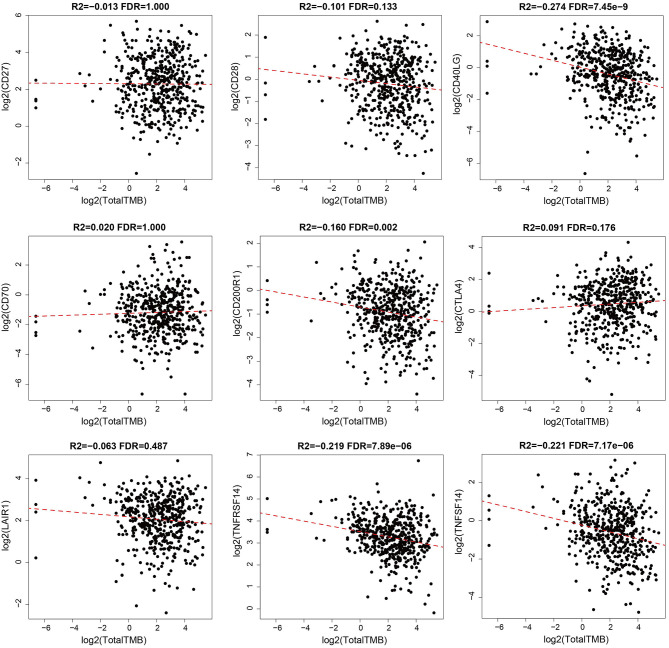
Correlation scatter diagram of IGCs' expression and tumor mutation burden (TMB). R2 is the correlation coefficient, and FDR is false discovery rate. The abscissa represents TMB, and the ordinate represents genes.